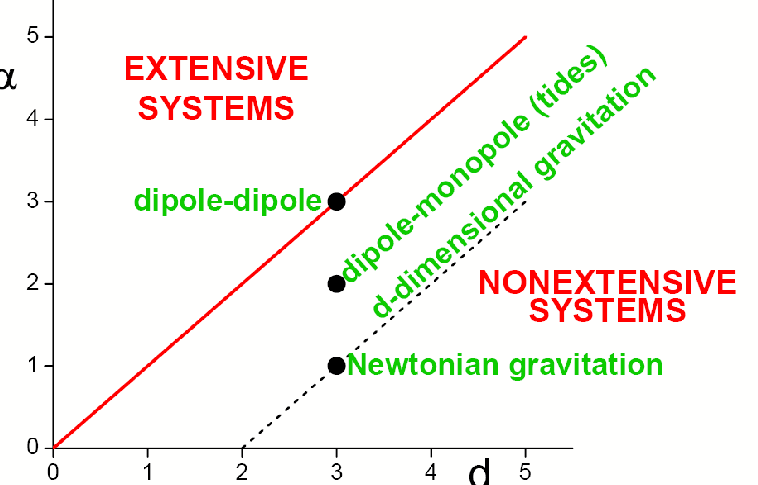
Figure 2. The classical systems for which α / d > 1 correspond to an extensive total energy and typically involve absolutely convergent series , whereas the so-called nonextensive systems (0 ≤ α / d < 1 for the classical ones) correspond to a superextensive total energy and typically involve divergent series . The marginal systems ( α / d = 1 here) typically involve conditionally convergent series , which therefore depend on the boundary conditions, i.e., typically on the external shape of the system. Capacitors constitute a notorious example of the α / d = 1 case. The model usually referred to in the literature as the Hamiltonian-Mean-Field (HMF) one [35] lies on the α = 0 axis (for all values of d > 0). The models usually referred to as the d -dimensional α -XY [36], α -Heisenberg [37–39] and α -Fermi–Pasta–Ulam (or α -Fermi–Pasta–Ulam–Tsingou problem [40,41]) [42–44] models lie parallel to the vertical axis at abscissa d (for all values of α ≥ 0). The standard Lennard–Jones gas is located at ( d , α ) = ( 3,6 ) . From